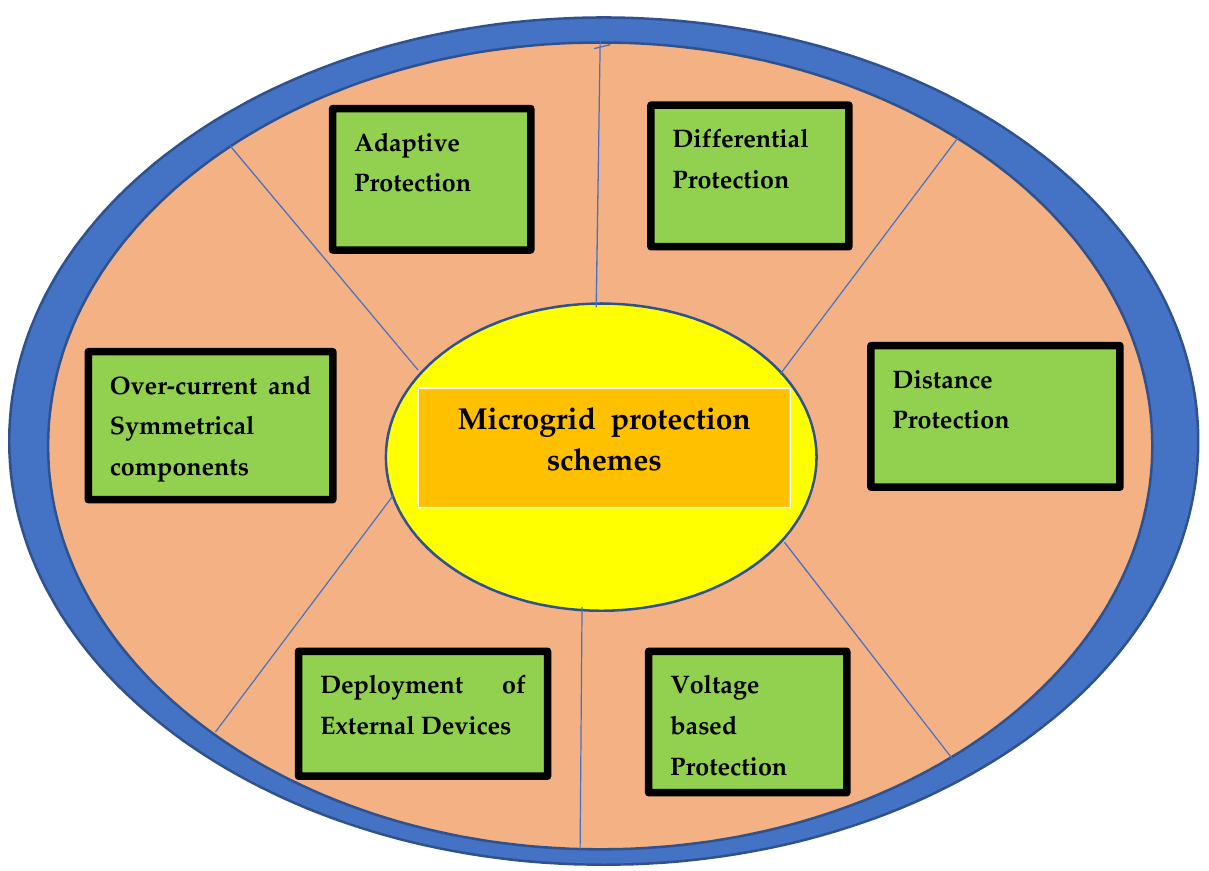
Figure 5. Protection schemes of microgrids.